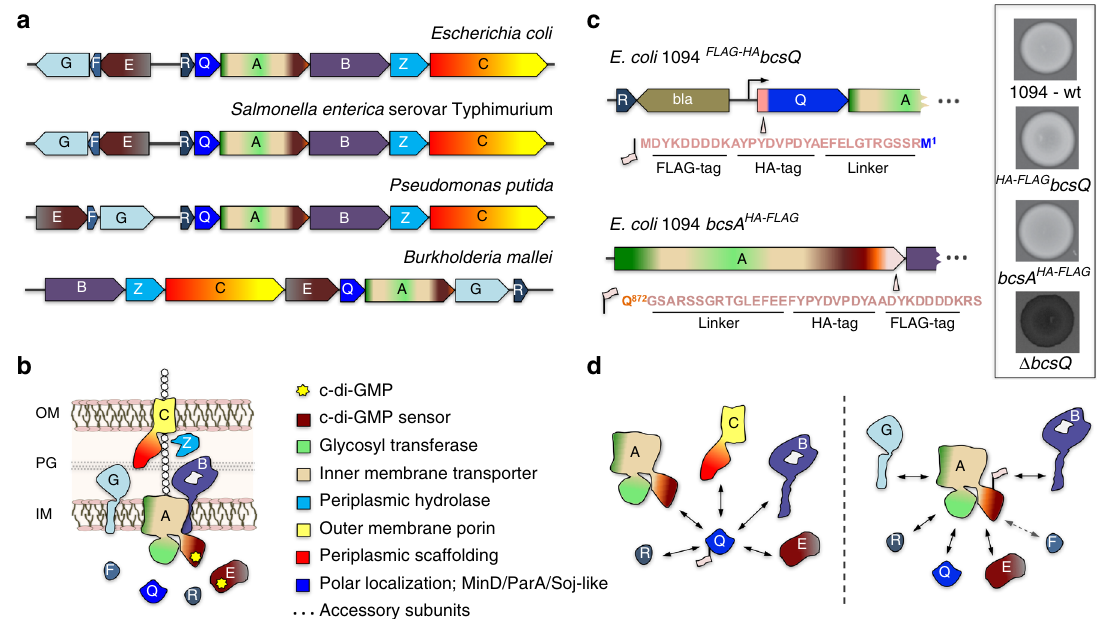
Fig. 1 E . coli -like cellulose secretion systems — components and macrocomplex detection. a E . coli bcs operon organization (top) and examples of organisms sharing E . coli- like cellulose secretion system conservation. b Predicted localization and function of the encoded Bcs components. Domain architectures for all Bcs proteins are detailed in Supplementary Fig. 1. c Chromosomal epitope-tagging of the BcsQ and BcsA subunits and functional validation of the recombinant proteins. The sequence of the respective N-terminal and C-terminal epitope tags is shown on the left; calco fl uor-binding and fl uorescence of the recombinant E . coli 1094 strains is shown on the right. d Thumbnail summary of co-purifying Bcs partners as determined by anti-FLAG af fi